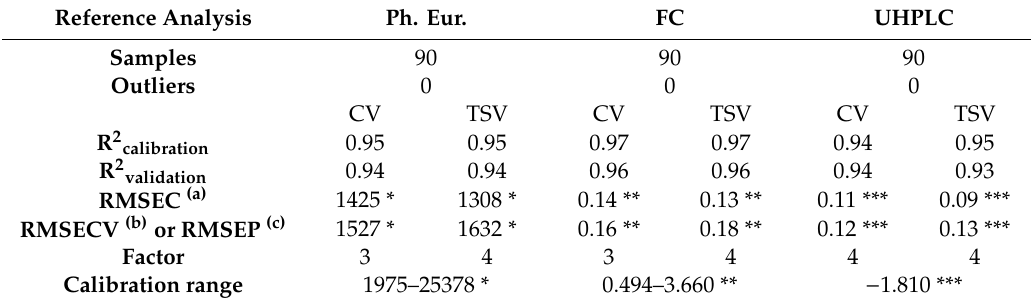
Table 3. Parameters of the established partial least squares regression PLSR models.